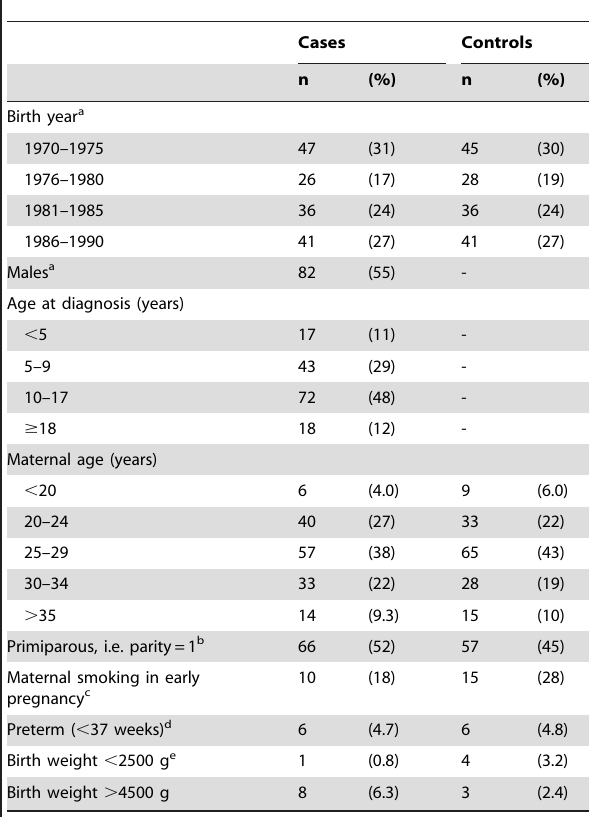
a Matching variable. b Data missing for 22 cases and 24 controls. c Data missing for 93 cases and 96 controls (data only available from 1983 and onwards). d Data missing for 22 cases and 24 controls. e Data missing for 22 cases and 26